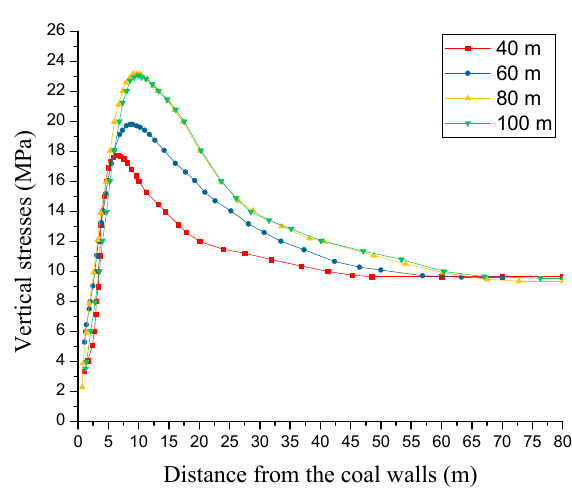
Figure 16. Front abutment pressure curves during the advancing of the coal face.